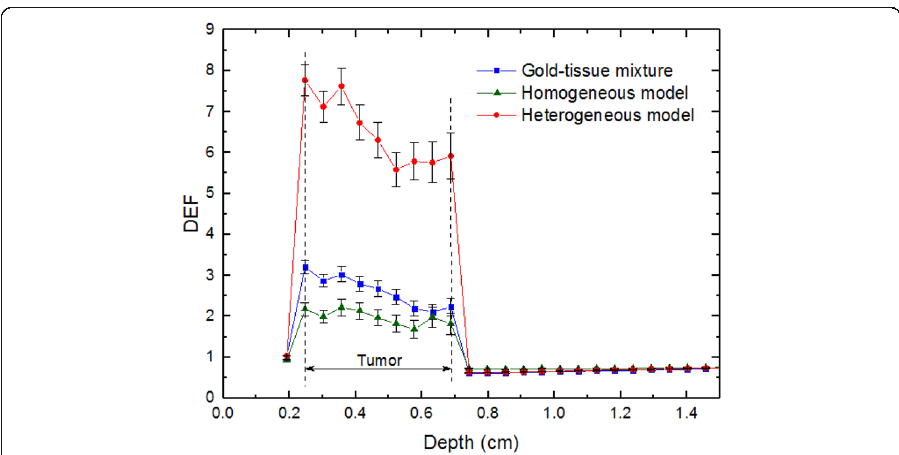
nm GNPs with a concentration of 30 mg/g of different models. Error bars indicate the relative